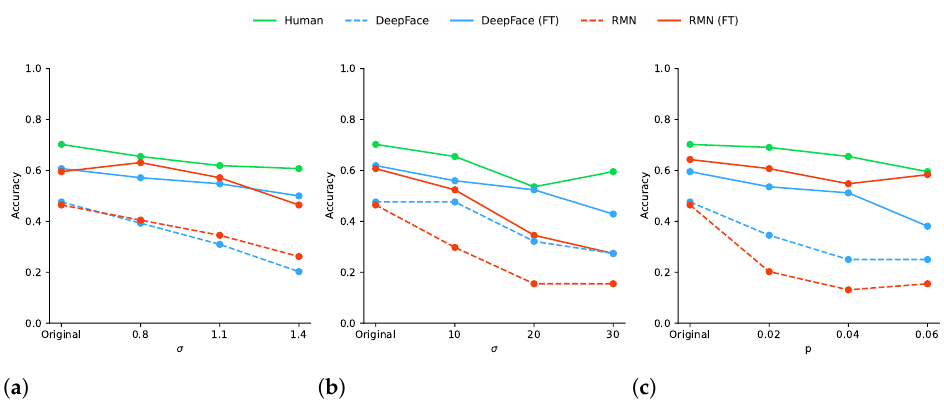
Figure 2. Illustration of the accuracy achieved by humans, pre-trained (i.e., DeepFace and RMN) and fine-tuned (FT) models, for each distortion type (i.e., GB, GN, and SP) and level. ( a ) Gaussian blur; ( b ) Gaussian noise; ( c ) salt-and-pepper